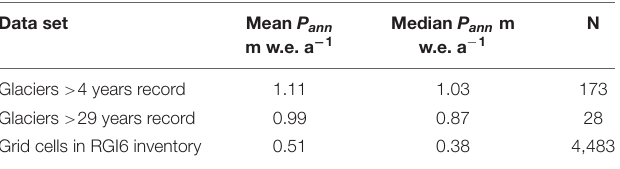
TABLE 4 | Mean and median annual precipitation from the Climatic Research Unit (CRU)/University of East Anglia (UEA) gridded climatology (New et al., 1999) for different glacier data